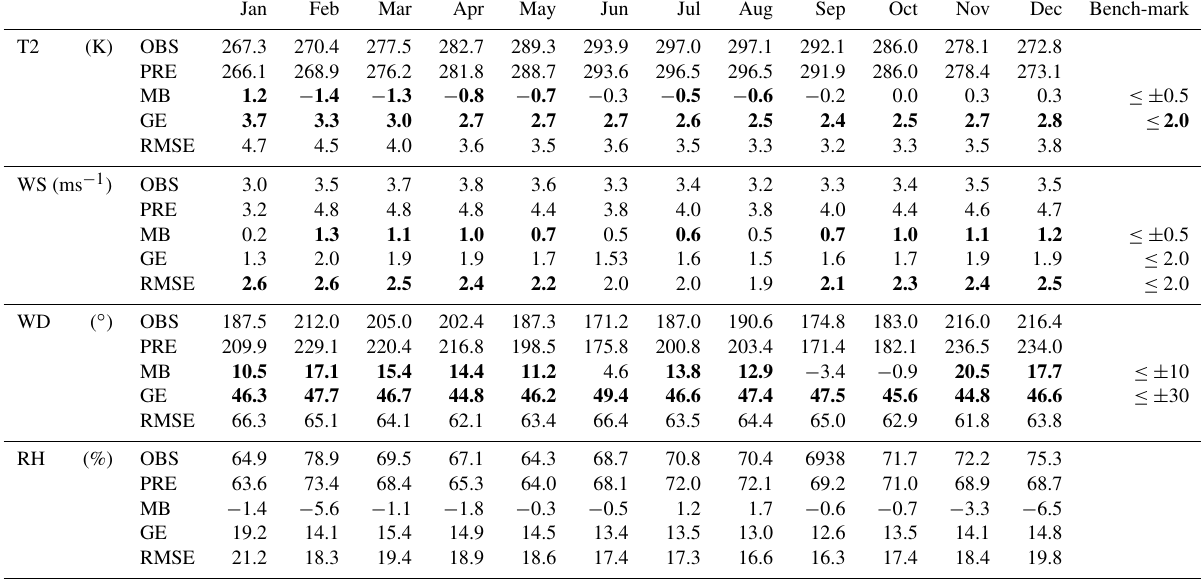
Table 1. Meteorology performance in all the months in 2013 (OBS is mean observation; PRE is mean prediction; MB is mean bias; GE is gross error; RMSE is root mean square error). The benchmarks are suggested by Emery et al. (2001) for the MM5 model in the eastern USA with 4–12km grid resolution. The values that do not meet the criteria are denoted in bold.